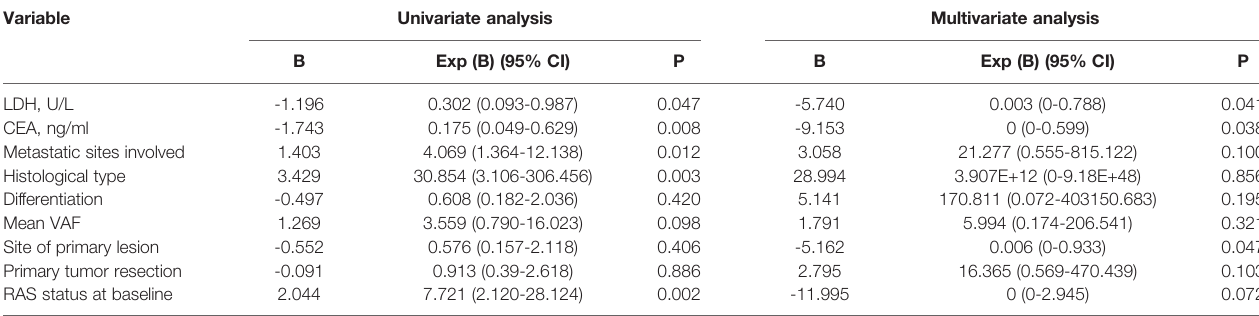
TABLE 3 | Univariate and multivariate analysis of overall survival (n=22).